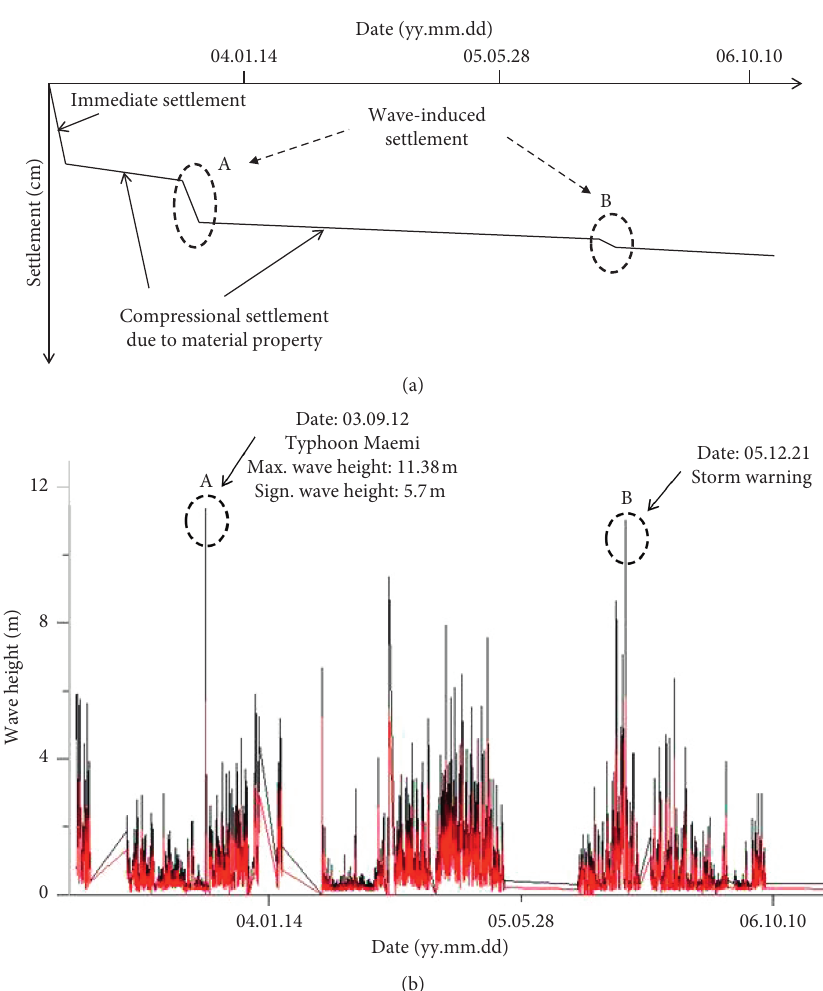
Figure 1: (a) Schematic diagram of caisson breakwater settlement history and (b) wave height history measured in the west breakwater of Jeju Outer